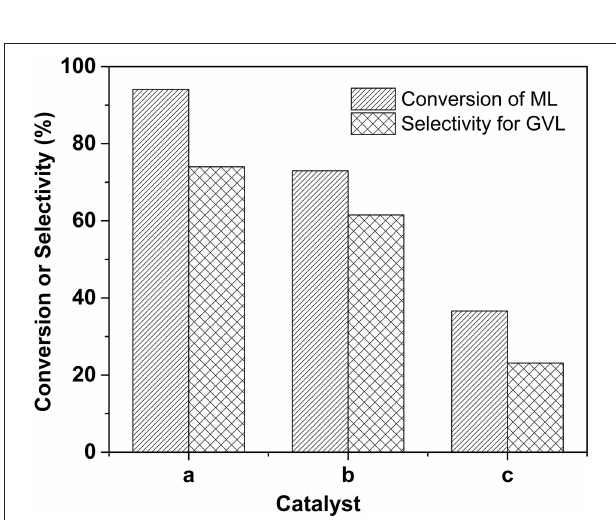
FIGURE 8 | Comparison of conversion and selectivity for various catalysts. Reaction conditions: 0.257g of ML, 50mg of 2.0% Ru/11.7% SiW@UiO − 66 for case a; 5mg of SiW + 50mg of 2.0% Ru/UiO − 66 for case b; 50mg of 2.0% Ru/UiO − 66 for case c, 15mL of H 2 O, 80 ◦ C, 0.5 MPa H 2 , during a 120min reaction